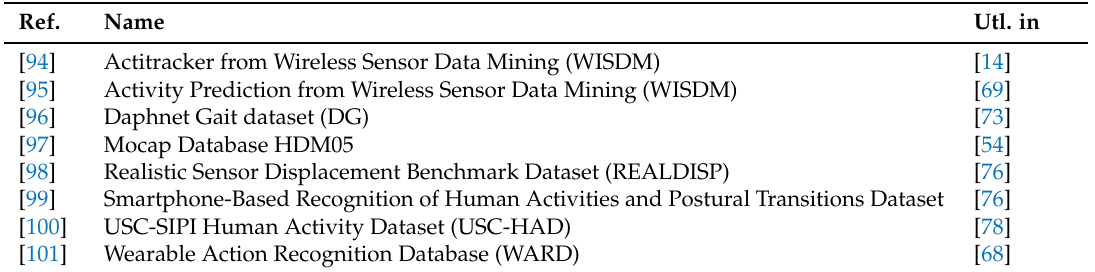
Table 8. Overview of publicly available datasets utilised by a single relevant contribution.